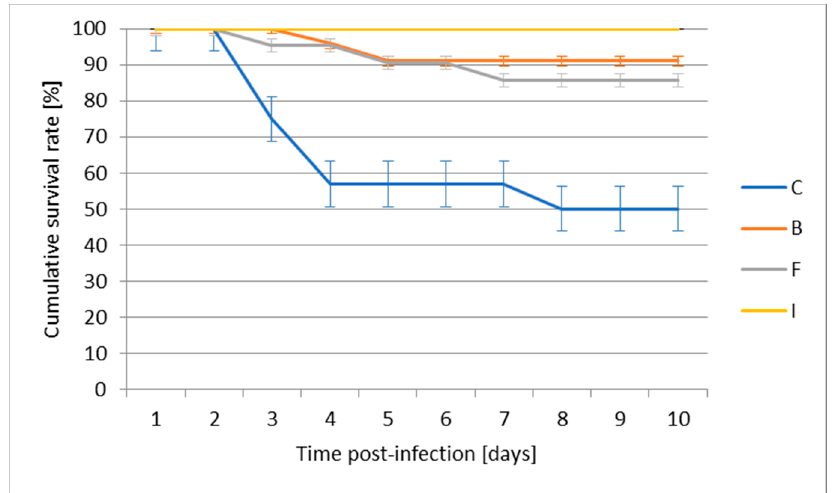
Figure 3. The effect of various routes of vaccination against A. salmonicida on the post-challenge survival rate of juvenile pikeperch.